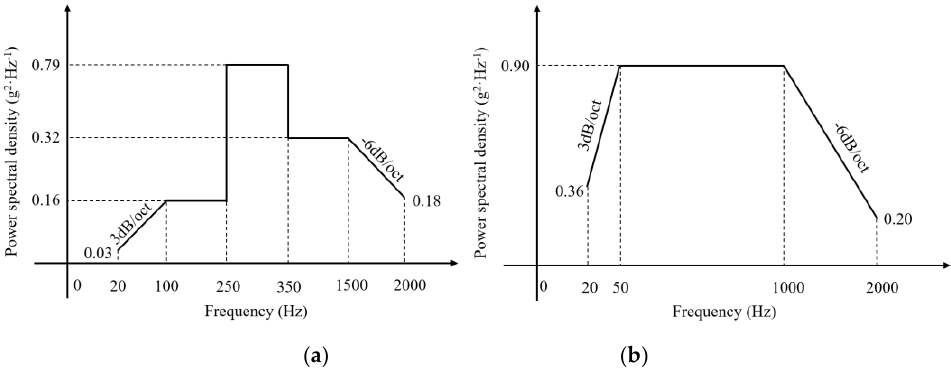
Figure 11. Profile of the two high frequency random vibrations. ( a ) High frequency random vibration 1. ( b ) High frequency random vibration 2. Table 1. High frequency random vibration condition 1.